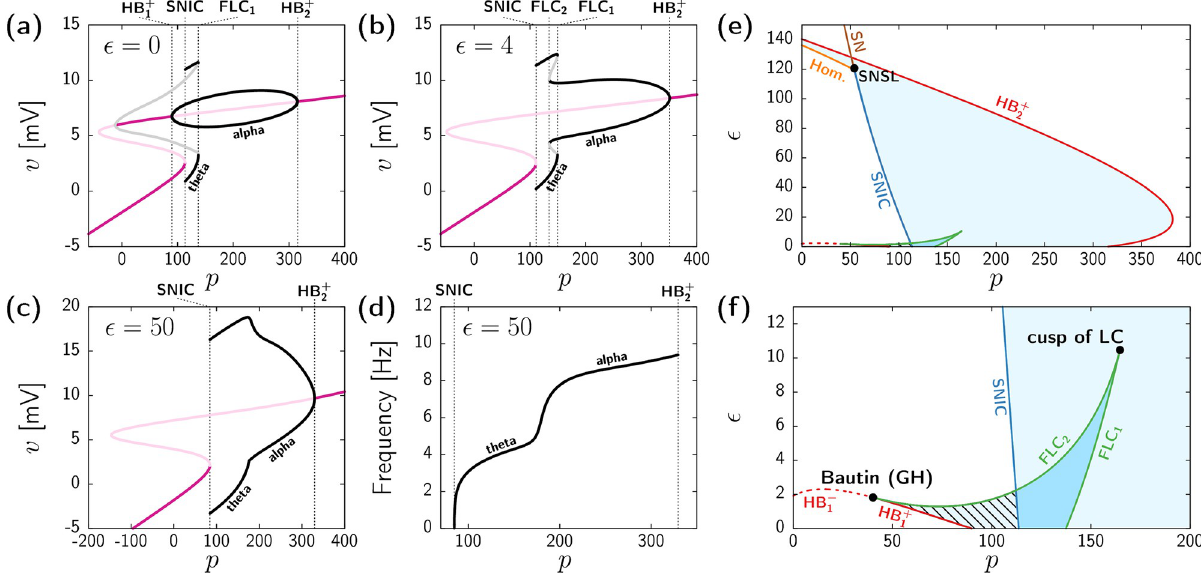
Fig 1. Bifurcation diagrams of the homogeneous states subject to uniform perturbations. (a-c) One-parameter bifurcation diagrams of Eq (18) obtained by varying p and with fixed � = 0 (a), � = 4 (b), and � = 50 (c). Colored curves indicate stable fixed points (dark pink), unstable fixed points (light pink), extrema of stable limit-cycles (black), and extrema of unstable limit-cycles (grey). Dashed black vertical lines indicate the relevant bifurcation points cited in the text. (d) Frequency of the stable oscillatory state by varying p and with fixed � = 50. (e,f) Two-parameter bifurcation diagram of Eq (18) depending on the external input p and the coupling strength � . Panel (f) is a zoomed version of (e). Curves indicate different bifurcation types: supercritical Hopf (HB + , continuous red), subcritical Hopf (HB − , dashed red), saddle-node (SN, brown), saddle-node in a invariant cycle (SNIC, dark blue), saddle-node of limit-cycles (FLC, green), and homoclinic (Hom., orange) The light-blue region indicates the existence of a single periodic state. The light-blue region with stripped black pattern indicates the coexistence between a limit-cycle and a fixed point. The dark-blue region indicates the coexistence of two stable periodic states. All results obtained by analyzing the system of Eq (18) using the bifurcation analysis software AUTO-07p (scripts for one-parameter bifurcations available at www.github.com/pclus/transverse-instabilities).